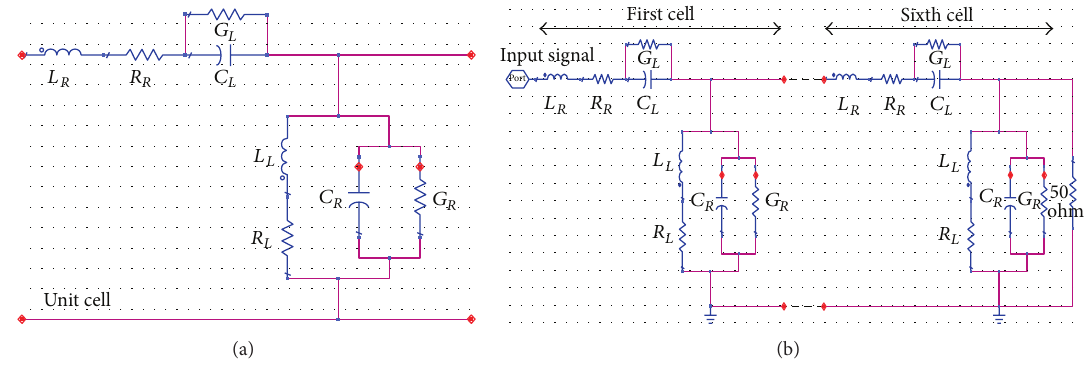
Figure 7: Equivalent circuit model of the second proposed antenna composed of six unit cells: (a) for one unit cell, (b) for whole structure.